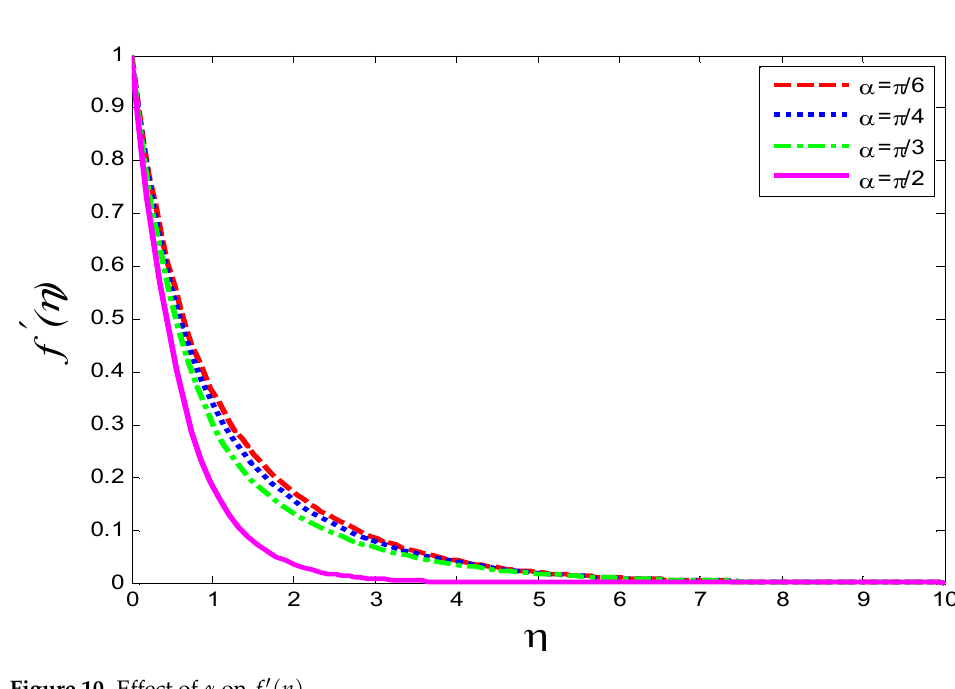
Figure 10. Effect of α on f (cid:48) ( η )